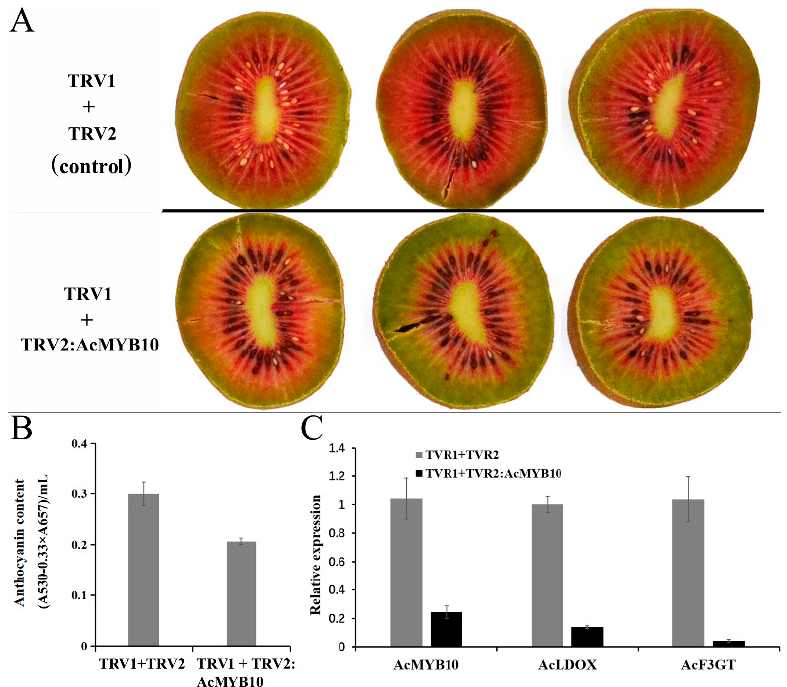
Figure 7. Functional analysis of AcMYB10 using virus-induced gene silencing (VIGS). ( A ) Silencing of AcMYB10 in ‘Hongshi No. 2 ′ fruits. The photograph was taken seven days after infiltration. ( B ) Anthocyanin content of treated fruits. ( C ) Expression level of AcMYB10 , AcLDOX and AcF3GT in the inner pericarp of treated fruits.